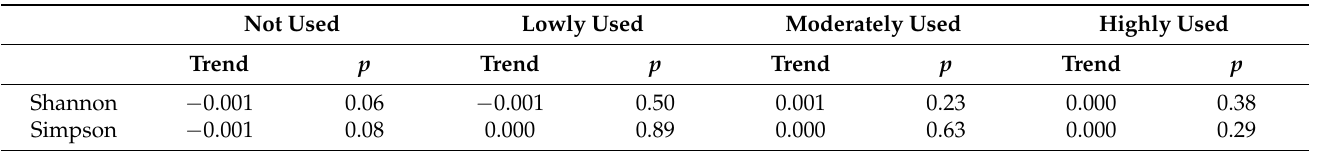
Table A2. Results of the trend analysis for the diversity of land cover classes calculated with Shannon and Simpson’s diversity indices and differentiating the time of sheep utilization (not used, lowly used, moderately used, and highly used). The trend column indicates the slope calculated with the Theil-Sen method (annual change for the variable of interest). p indicates the degree of significance according to the Mann-Kendall test.